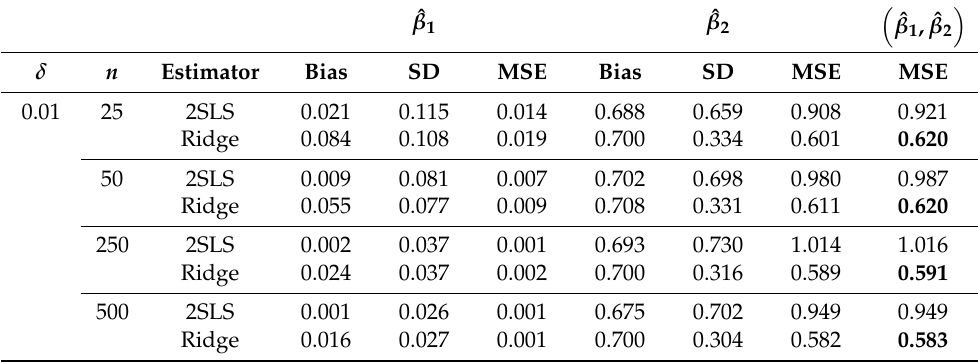
Table A3. The simulated model is given by Equations (1), (2), (4) and (12) with k = 2, m = 4, z i ∼ iid N ( 0, I 4 ) , and β 0 = ( 0,0 ) (cid:48) . Summary statistics are reported for estimates of ˆ β 1 and ˆ β 2 using strength of the instrument ( δ ) and sample size ( n ). Each model is simulated 10,000 times. The ridge estimator outperforms the 2SLS estimator in terms of MSE values in a number of cases. In particular, in small samples and low precision settings, the ridge estimator leads to smaller MSE